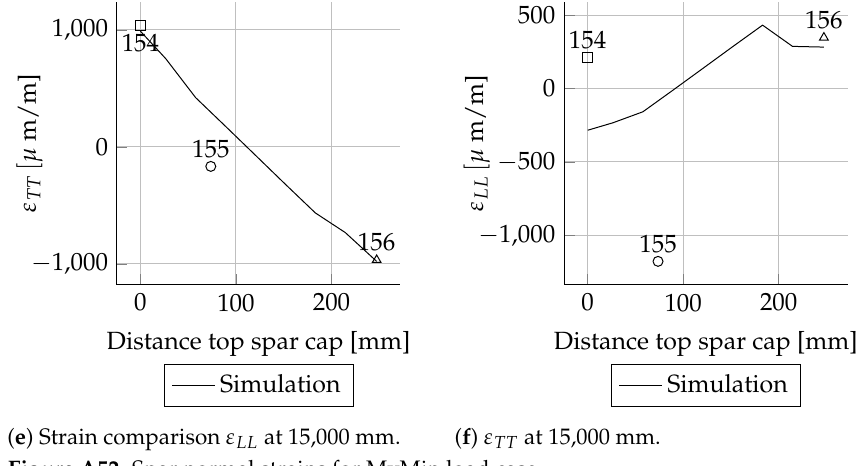
Figure A52. Spar normal strains for MyMin load case.